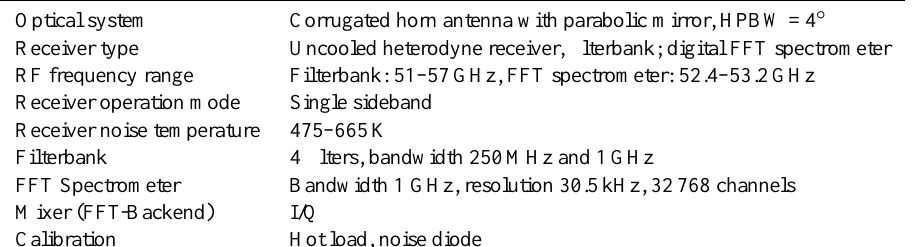
Table 1. Specifications of TEMPERA.